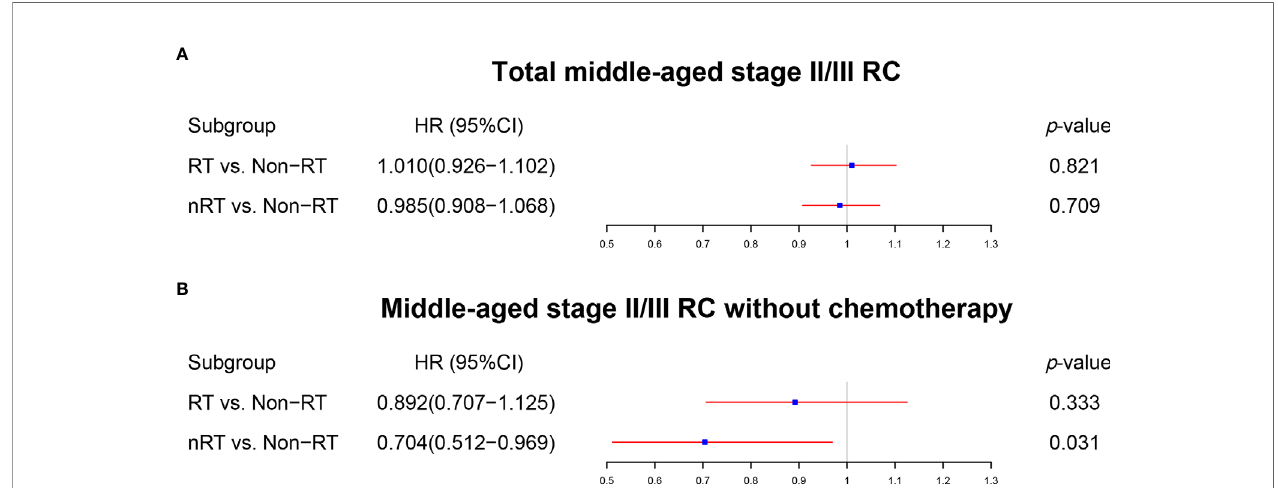
FIGURE 4 | The forest plot was used to show the results of the multivariable Cox regression in middle-aged stage II/III RC patients. (A) RT vs . non-RT and nRT vs . non-RT in total middle-aged stage II/III RC patients. (B) RT vs . non-RT and nRT vs . non-RT in middle-aged stage II/III RC patients without chemotherapy. (The results were extracted from Table S3 ).